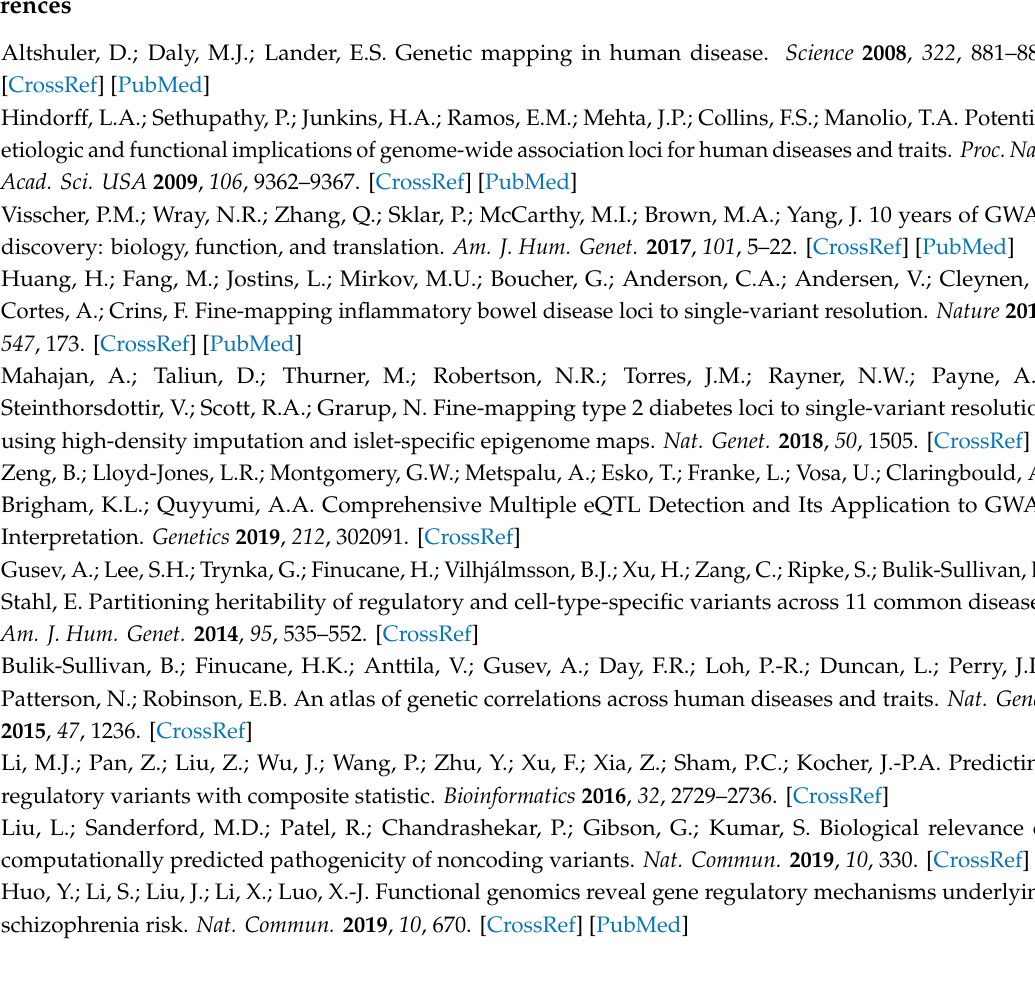
Figure S1: Characteristics of neutrophils by immunofluorescence and flow cytometry analysis, Figure S2: Characteristics of monocytes by flow cytometry analysis, Figure S3: Venn diagram of di ff erential expressed genes, Figure S4: Gene ontology and pathway analysis of di ff erential expression genes in HL60 monocyte derivatives, Figure S5: Gene ontology and pathway analysis of di ff erential expression genes in HL60 neutrophil derivatives; Figure S6: Gene ontology and pathway analysis of di ff erential expression genes in HL60 / S neutrophil derivatives, Figure S7: Gene ontology enrichment analysis of di ff erential expression genes in HL60 and HL60 / S4 monocyte and neutrophil derivatives, Figure S8: Quantification of all targeted gene expression normalized by GAPDH in all data, Table S2: Fluidigm qRT-PCR samples phenotype, Table S3a: Genotype of single-cell clones used in this study, Table S3b: The number of sequenced single-cell clones, clones with Indels, and clones with SNP removal at both alleles, Table S4a: Monocyte di ff erentiation e ffi ciencies of HL60, HL60 / S4, and HL60 clones; drug-treated groups are in duplicates, Table S4b: CD11b +/ 7-AAD- cell proportion of di ff erentiated neutrophils and negative control cells analyzed by flow cytometry, Table S5: O ff -target analysis of gRNA designs with up to two